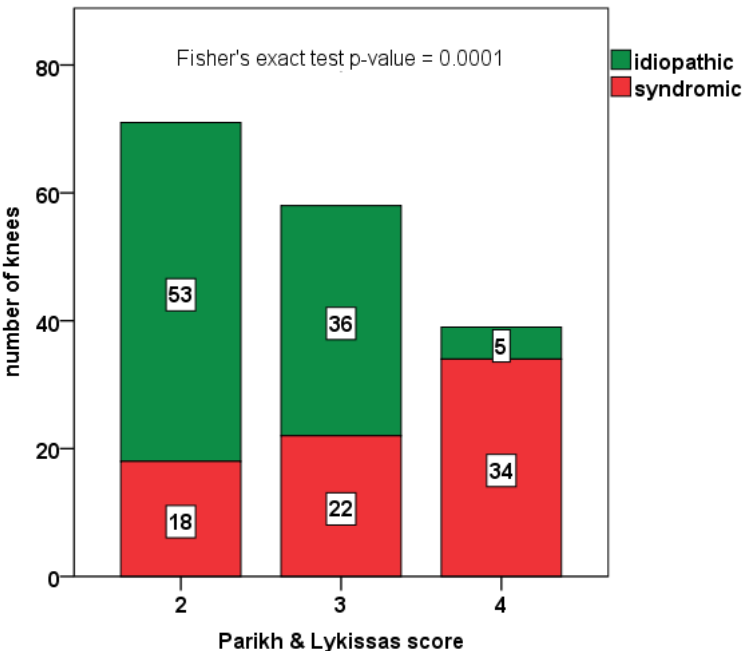
Figure 2. Distribution of idiopathic (depicted in green) and syndromic knees with patellar instability (depicted in red) in groups by Parikh and Lykissas score. Fisher’s exact test p -value = 0.0001.